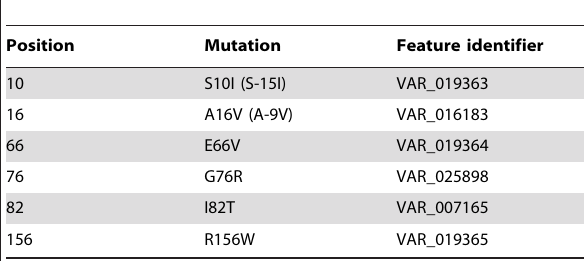
Table 1. Summary of identified SOD2